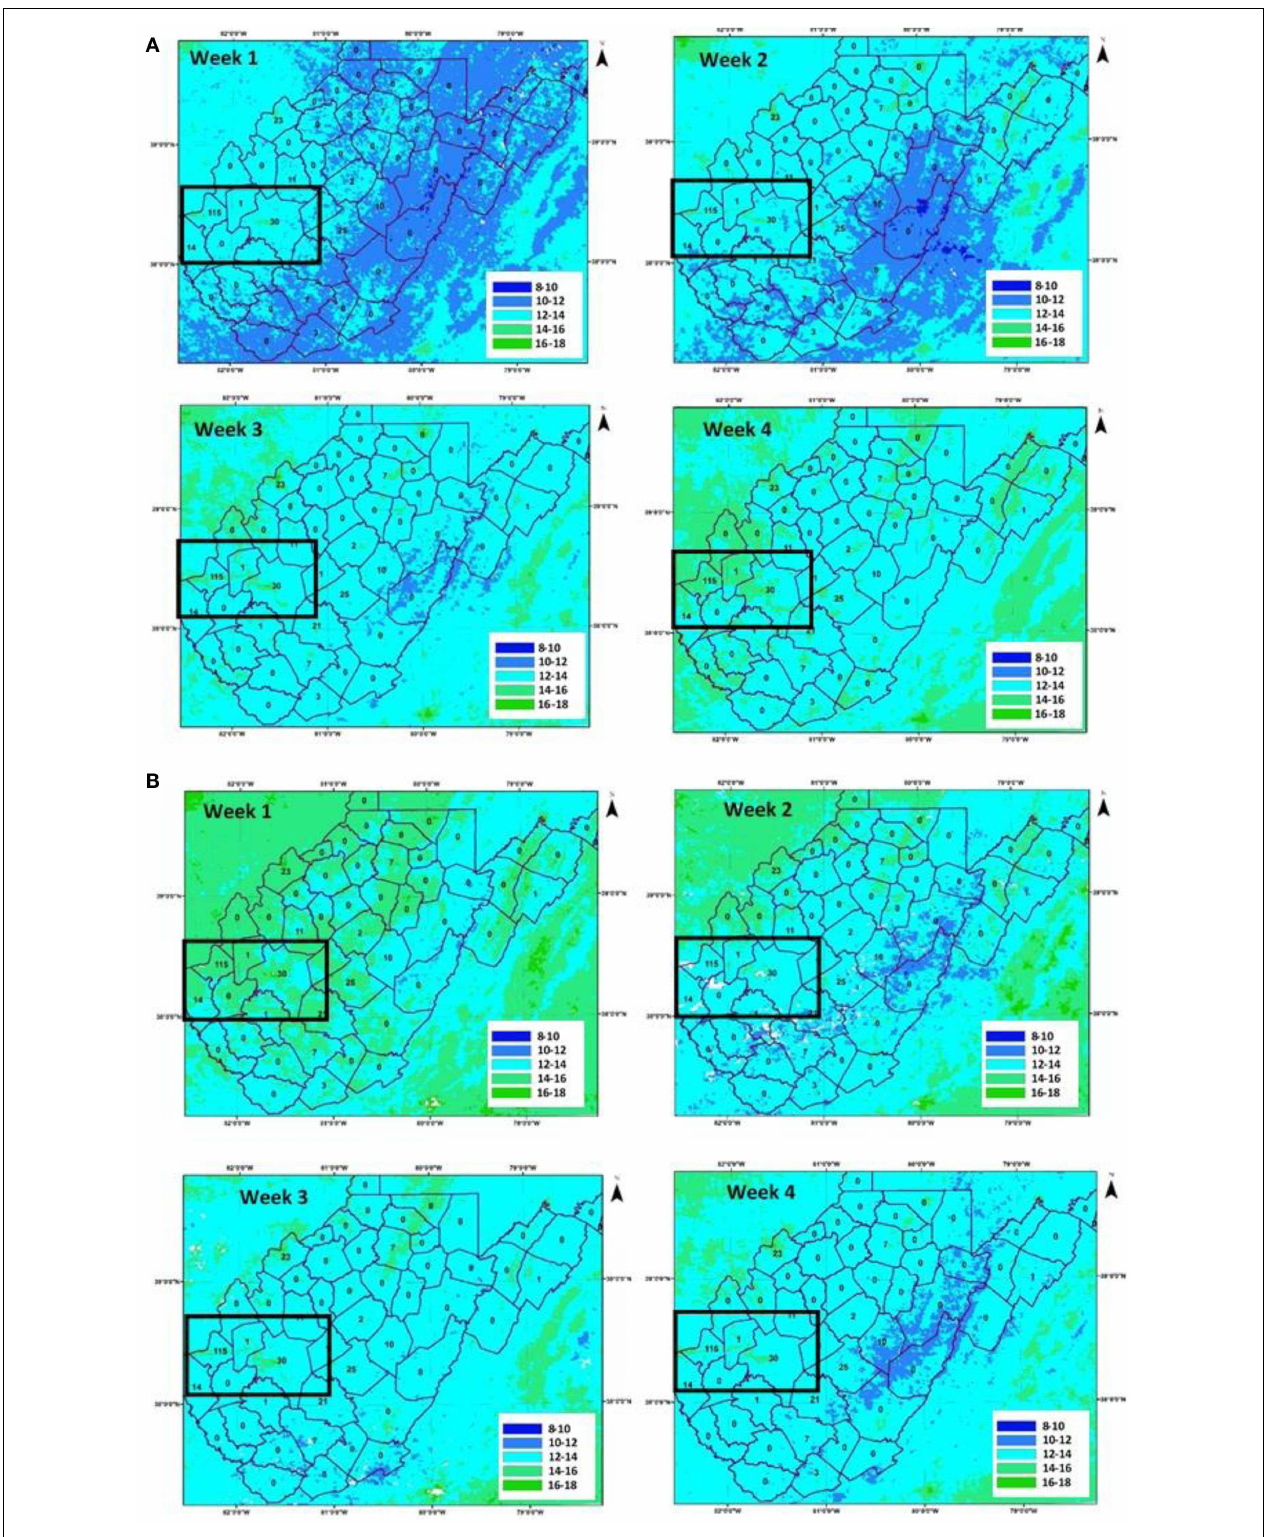
FIGURE 2 | Land surface temperature (°C) for (A) June 2012 and (B) July 2012 . (Black box in the figure – 38.6825°N to 37.8788°N; 82.5844°W to 81.0955°W; and include Cabell and Kanawha counties